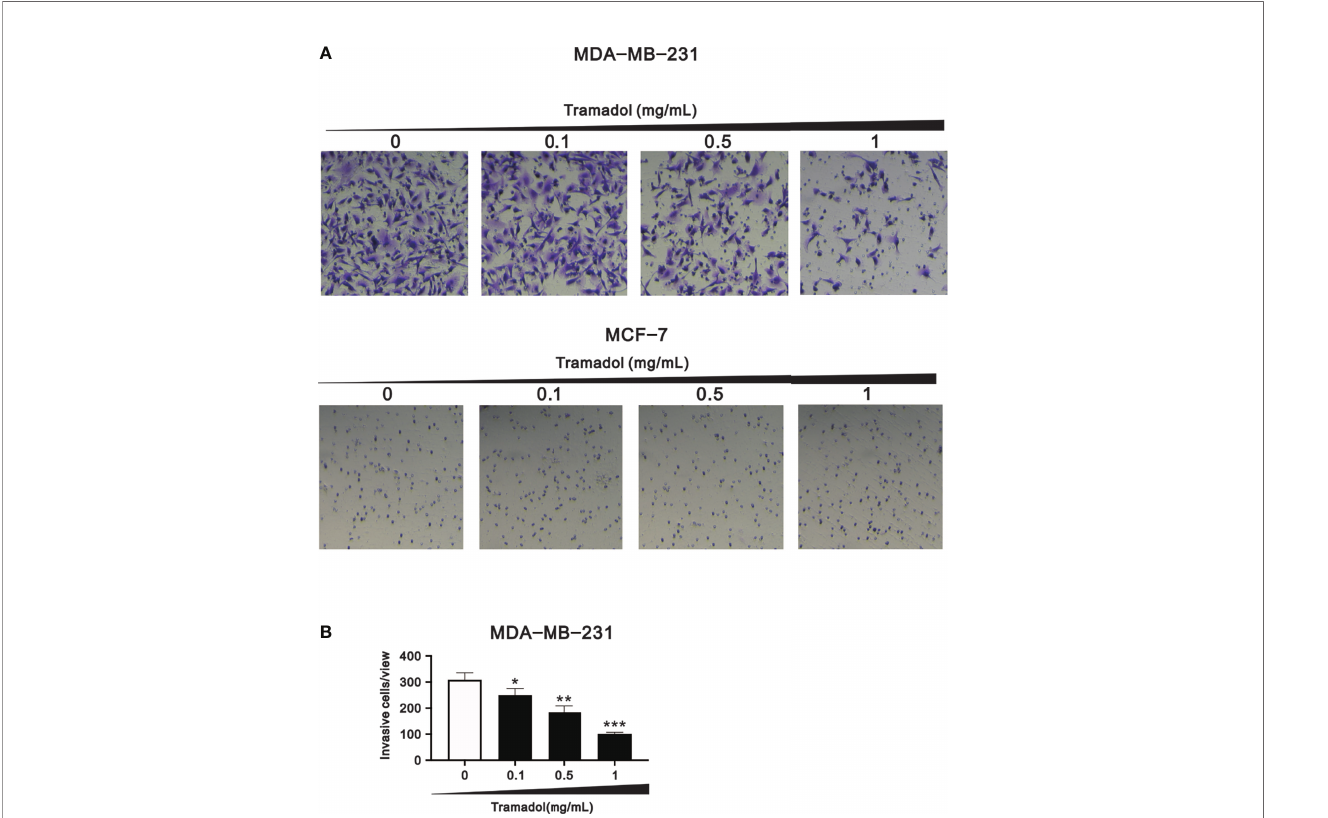
FIGURE 4 | Analysis of the effect of tramadol on the invasiveness of human breast cancer cells. (A, B) MDA-MB-231 and MCF-7 cells were treated with tramadol (0, 0.1, 0.5 and 1 mg/mL) for 24 h. Bars depict the mean ± SD of three independent experiments. * p < 0.05, ** p < 0.01 and *** p < 0.001 (Student ’ s t -tests). Bars depict the mean ± SD of three independent